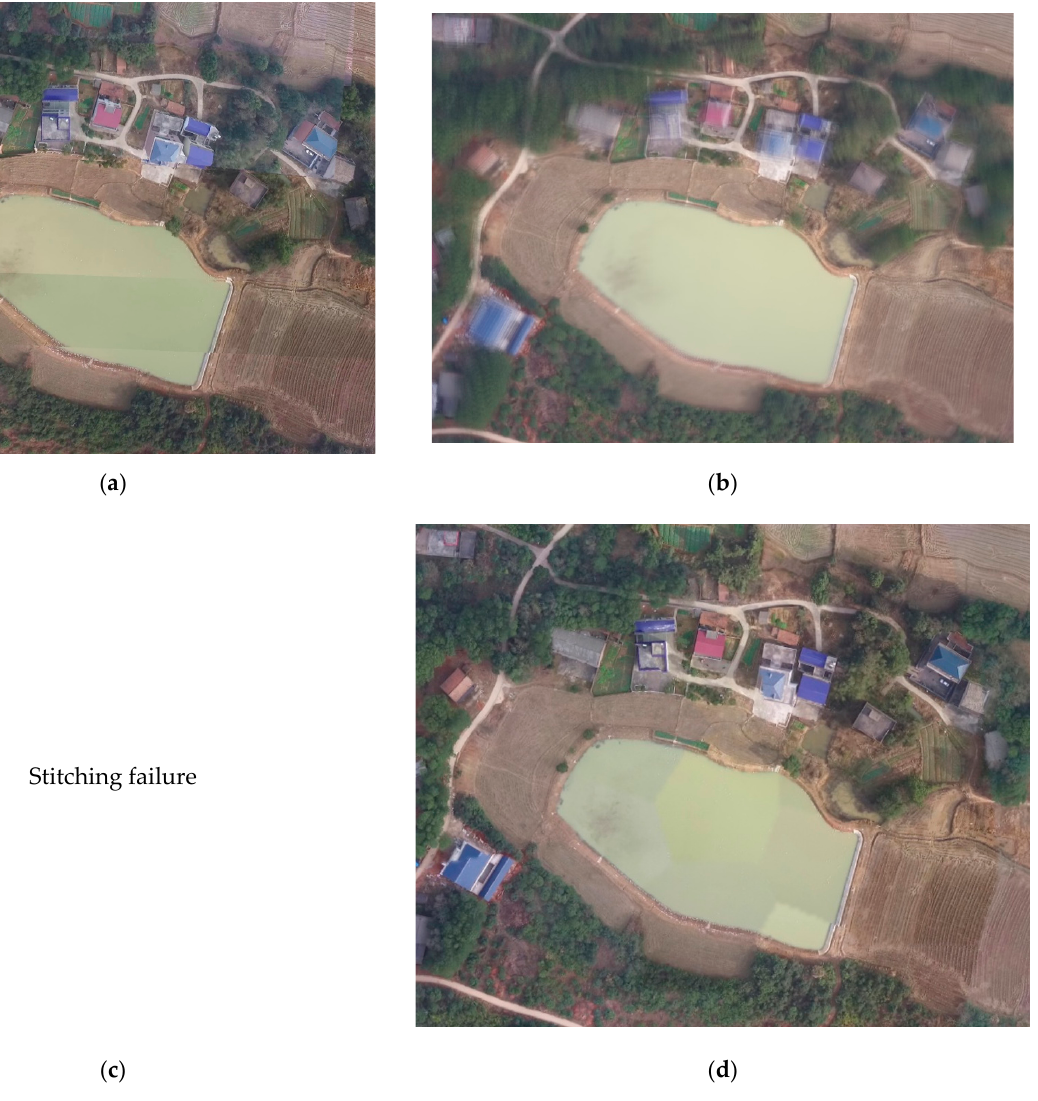
Figure 18. Comparison of house in panorama using different methods. ( a ) QuickBird. ( b ) AutoPano. ( c ) Opencv-Stitcher. ( d ) Our method.